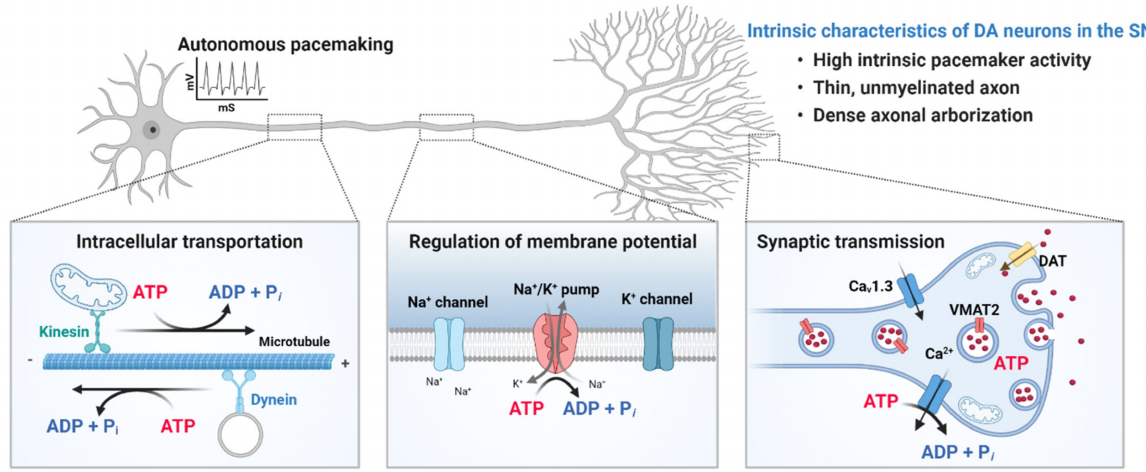
Figure 2. Intrinsic properties of dopaminergic (DA) neurons in the substantia nigra (SN). The nigrostriatal DA neurons are autonomous pacemakers, and their tonic spontaneous activity is important for the sustained release of dopamine in target structures, such as the striatum. In addition, DA neurons in the SN have thin, unmyelinated axons with an extraordinary large axonal arbor and a very high number of synaptic terminals. The size and complexity of DA neurons in the SN impose a high metabolic burden to produce ATP, which is required for transporting cellular components to appropriate locations, maintaining resting membrane potential, generating and propagating action potential, and regulating synaptic transmission. Metabolically active DA neurons in the SN are susceptible to mitochondrial dysfunction, which is a prominent feature of both aging and PD. Created with